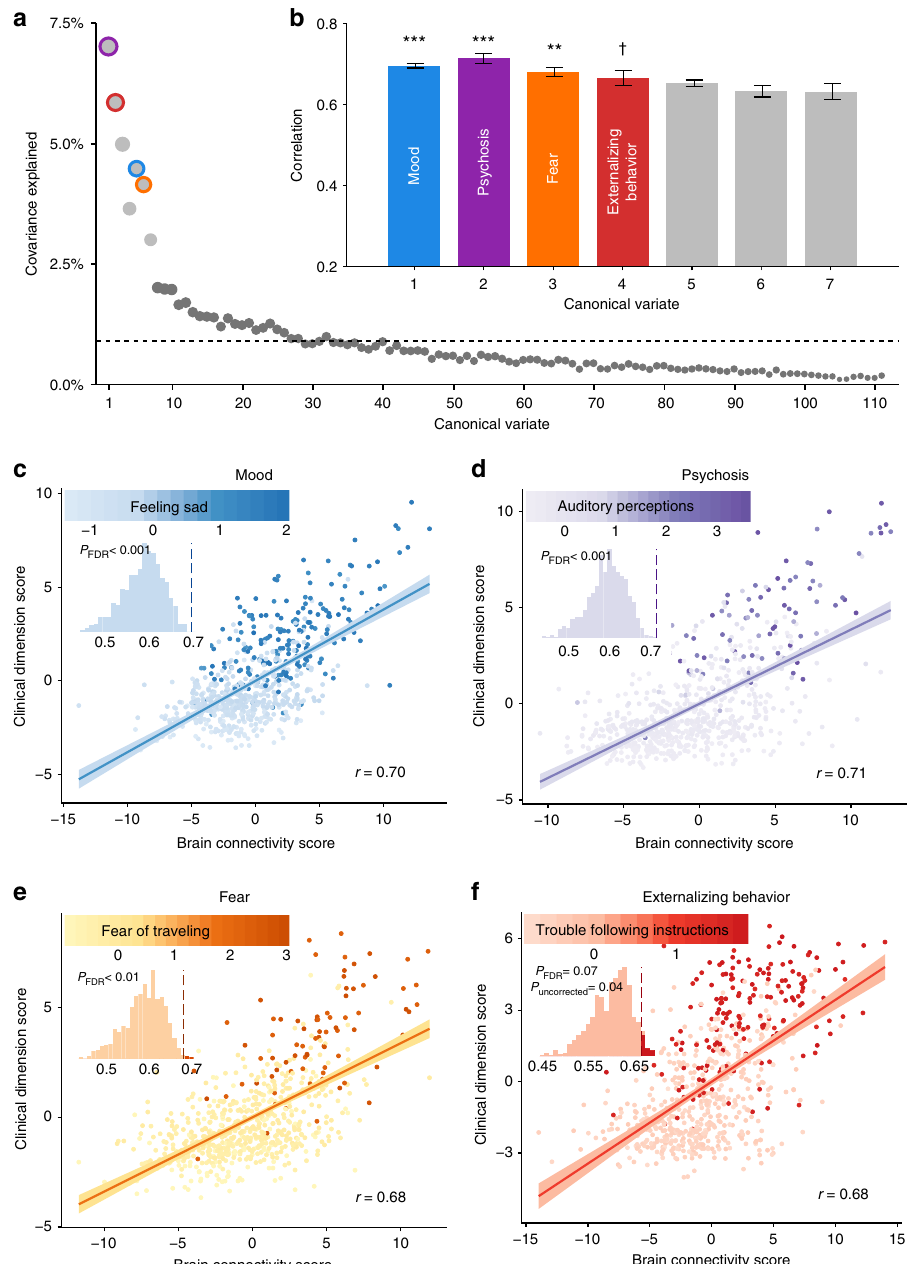
Fig. 3 sCCA reveals multivariate patterns of linked dimensions of psychopathology and connectivity. a The fi rst seven canonical variates were selected based on covariance explained. Dashed line marks the average covariance explained. b Three canonical correlations were statistically signi fi cant by permutation testing with FDR correction ( q < 0.05), with the fourth one showing an effect at uncorrected thresholds. Corresponding variates are circled in ( a ). Error bars denote standard error. Dimensions are ordered by their permutation-based P value. c – f Scatter plots of brain and clinical scores (linear combinations of functional connectivity and psychiatric symptoms, respectively) demonstrate the correlated multivariate patterns of connectomic and clinical features. Colored dots in each panel indicate the severity of a representative clinical symptom that contributed the most to this canonical variate. Each insert displays the null distribution of sCCA correlation by permutation testing. Dashed line marks the actual correlation. *** P FDR < 0.001, ** P FDR < 0.01, † P uncorrected = < 10 − 8 , P FDR < 10 − 7 , respectively). We did not observe age by sex for statistically rigorous modeling of both linear and non-linear interaction effects in any dimension. effects while minimizing over- fi tting. Using this approach, we found that the brain connectivity patterns associated with both mood and psychosis became signi fi cantly more prominent with age (Fig. 7a, b, P FDR < 10 − 13 , P FDR < 10 − 6 , respectively). Addi- tionally, brain connectivity patterns linked to mood and fear were both stronger in female participants than males (Fig. 7c, d, P FDR